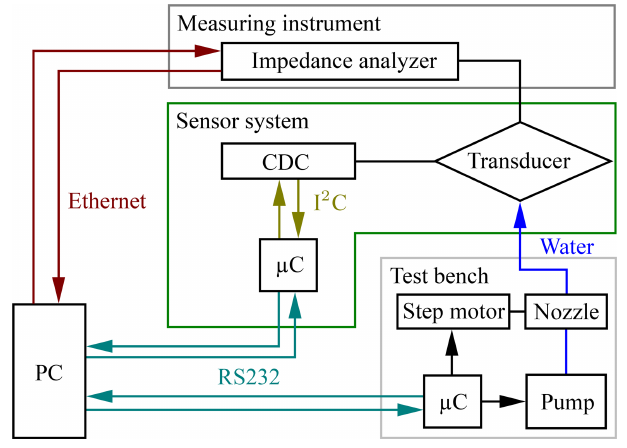
Figure 6. Block diagram of the experimental setup for measure- ments with a measuring instrument or a sensor